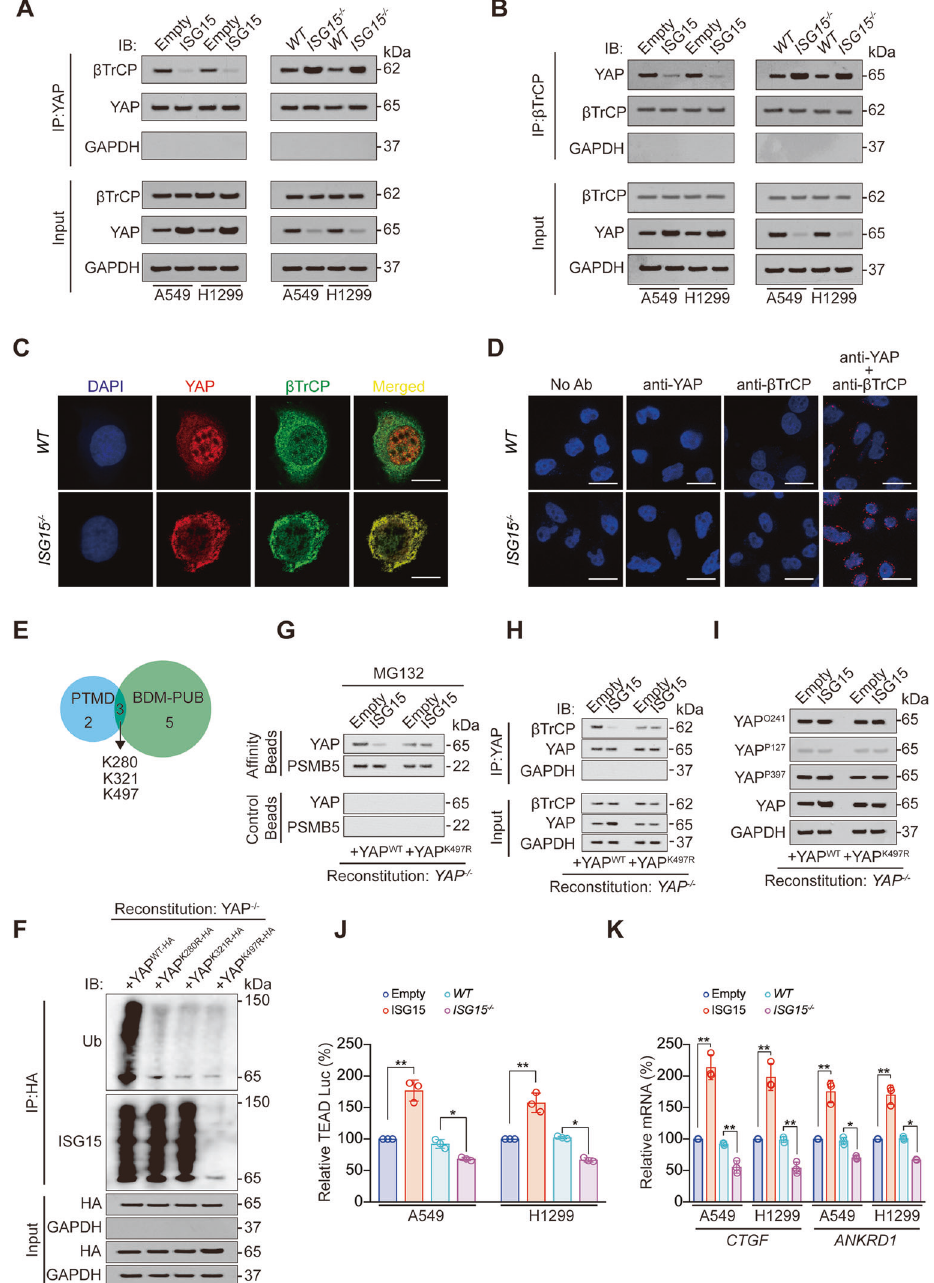
Fig. 2 YAP ISGylation inhibits its interaction with β TrCP and promotes downstream transcription. A , B Co-IP was performed in control, ISG15 overexpression or knockout A549 and H1299 cells using anti-YAP ( A ) or anti- β TrCP ( B ) antibodies. The YAP ( A ) or β TrCP ( B ) level in each co-IP sample was adjusted to the same protein content. Indicated proteins were further analyzed by IB. C Co-localization of YAP and β TrCP was analyzed in WT or ISG15 − / − A549 cells before being photographed using a confocal microscope. Scale bar, 20 μ m. D Proximal protein ligation between YAP and β TrCP, as photographed by confocal microscope in WT or ISG15 − / − A549 cells Scale bar, 50 μ m. E YAP ubiquitination sites analyzed by PTMD and BDM-PUB databases. F Co-IP was performed in YAP − / − reconstituted A549 cells with YAP WT-HA , YAP K280R-HA , YAP K321R-HA , or YAP K497R-HA expressed. The YAP level in each co-IP sample was adjusted to the same protein content. G Association of YAP and PSMB5 analyzed by IB in proteasomes isolated from YAP − / − reconstituted A549 cells with ISG15, YAP WT-HA or YAP K497R-HA expressed in the presence of MG132 (8 μ M, 24 h). Samples from af fi nity or control beads were analyzed in parallel. H Co-IP was performed using anti-YAP antibodies in YAP − / − reconstituted A549 cells with ISG15, YAP WT-HA or YAP K497R-HA expressed. The YAP level in each co-IP sample was adjusted to the same protein content. Indicated proteins were further analyzed by IB. I O-GlcNAcylation of YAP at T241 (YAP O241 ), phosphorylation of YAP at S127 (YAP P127 ) and S397 (YAP P397 ) was analyzed in YAP − / − reconstituted A549 cells with ISG15, YAP WT-HA or YAP K497R-HA expressed by IB. J , K Relative TEAD Luc ( J ), CTGF and ANKRD1 mRNA level ( K ) were measured using a pUAS-Luc/TEAD-Gal4 system in control, ISG15 overexpression or knockout A549 and H1299 cells. The data are shown as the mean ± SD from three biological replicates (including IB). Data in J , K were analyzed using a one-way ANOVA test. ** P < 0.01, * P < 0.05.